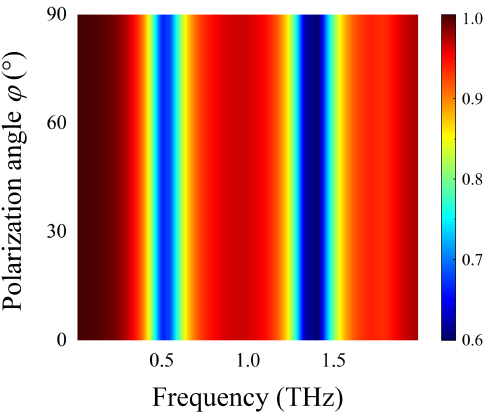
Figure 15. Transmission spectra of lactose-covered DAIGS at different polarization angle ϕ under the vertically incidence